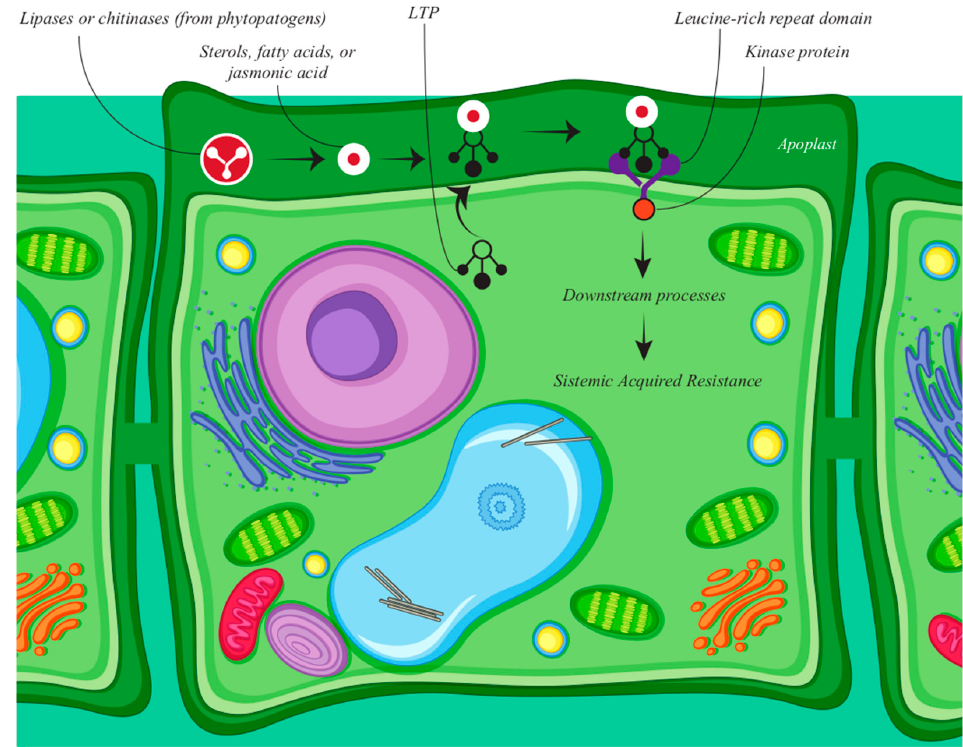
Figure 3. Schematic representation of the defense response and systemic acquired resistance events including the participation of LTPs in a plant cell.